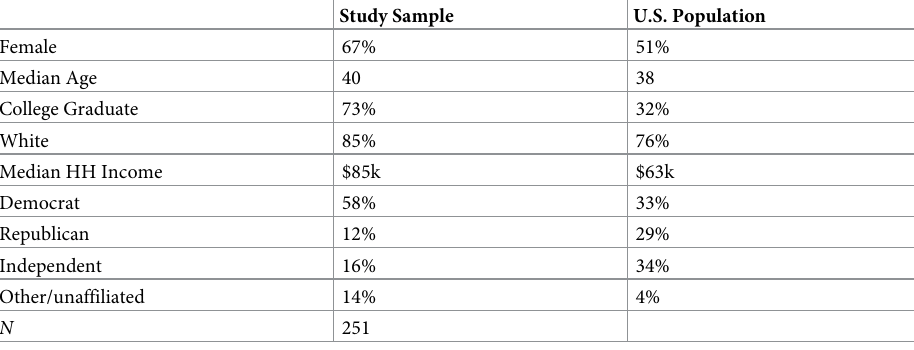
Table 1. Sample composition compared to US